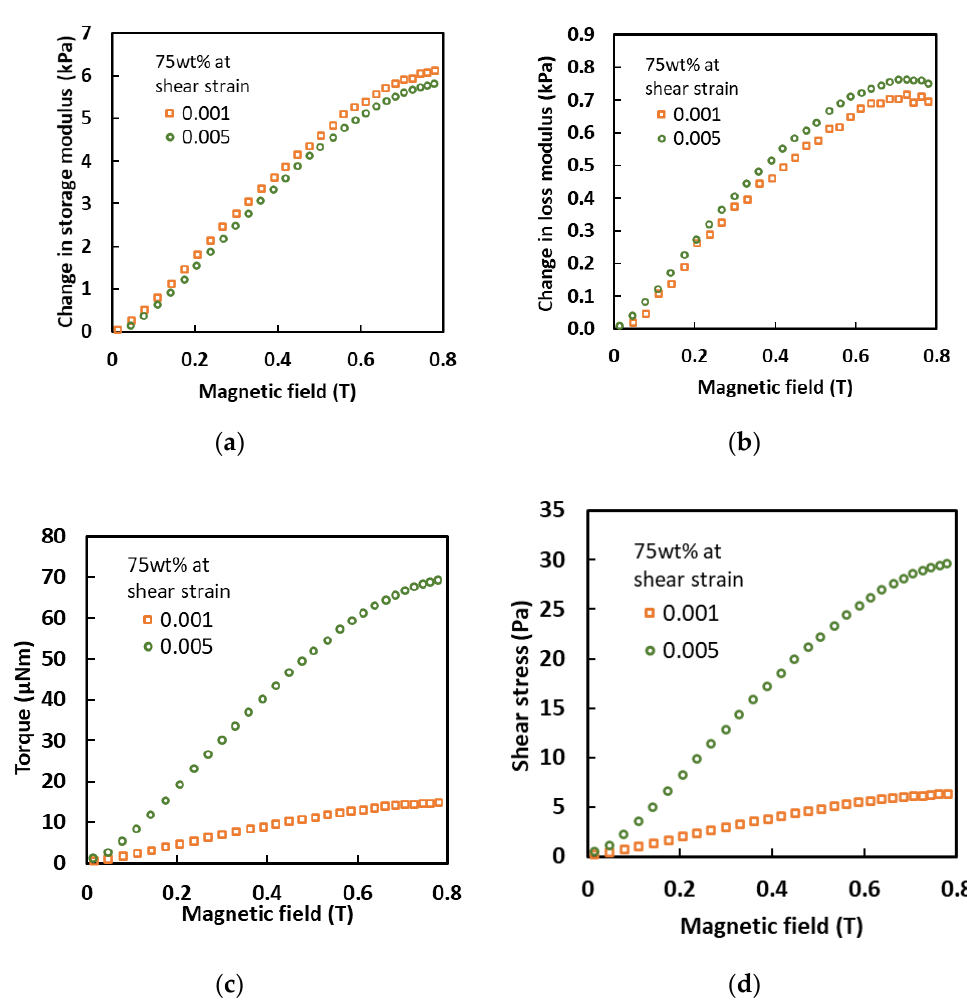
Figure 8. Relationship of ( a ) storage modulus, ( b ) loss modulus, ( c ) torque and ( d ) shear stress with various magnetic fields at different shear strains.